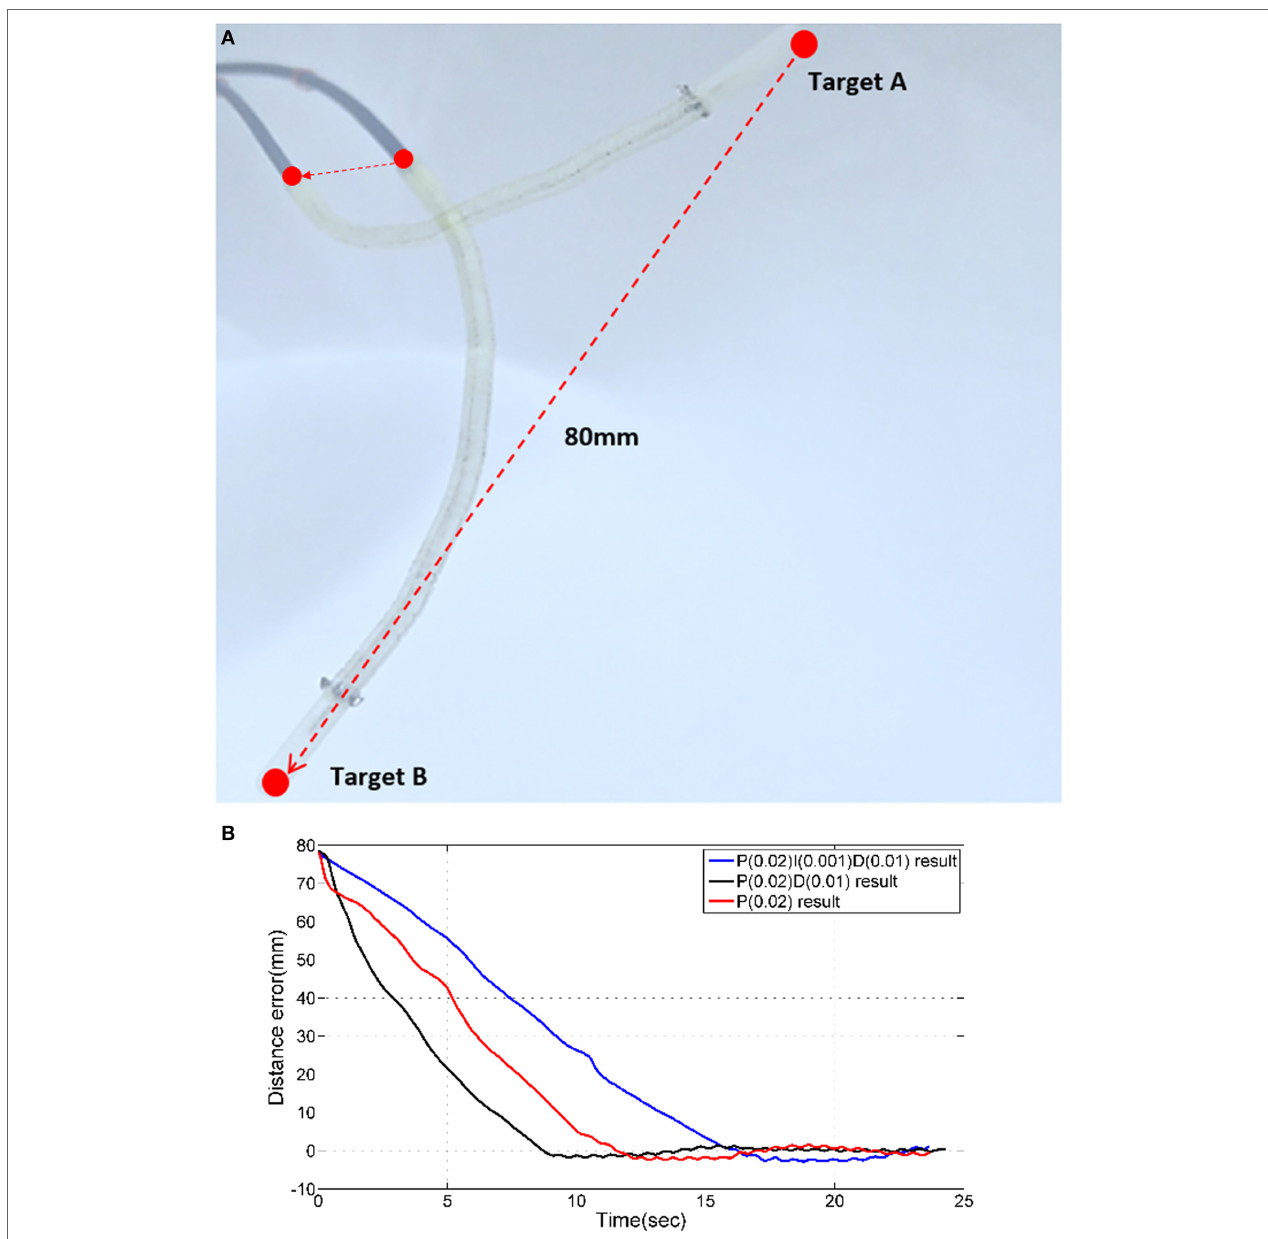
FigUre 9 | (a) Two targets for PID time response experiments. (B) Time responses of PID, PD, and P controllers.